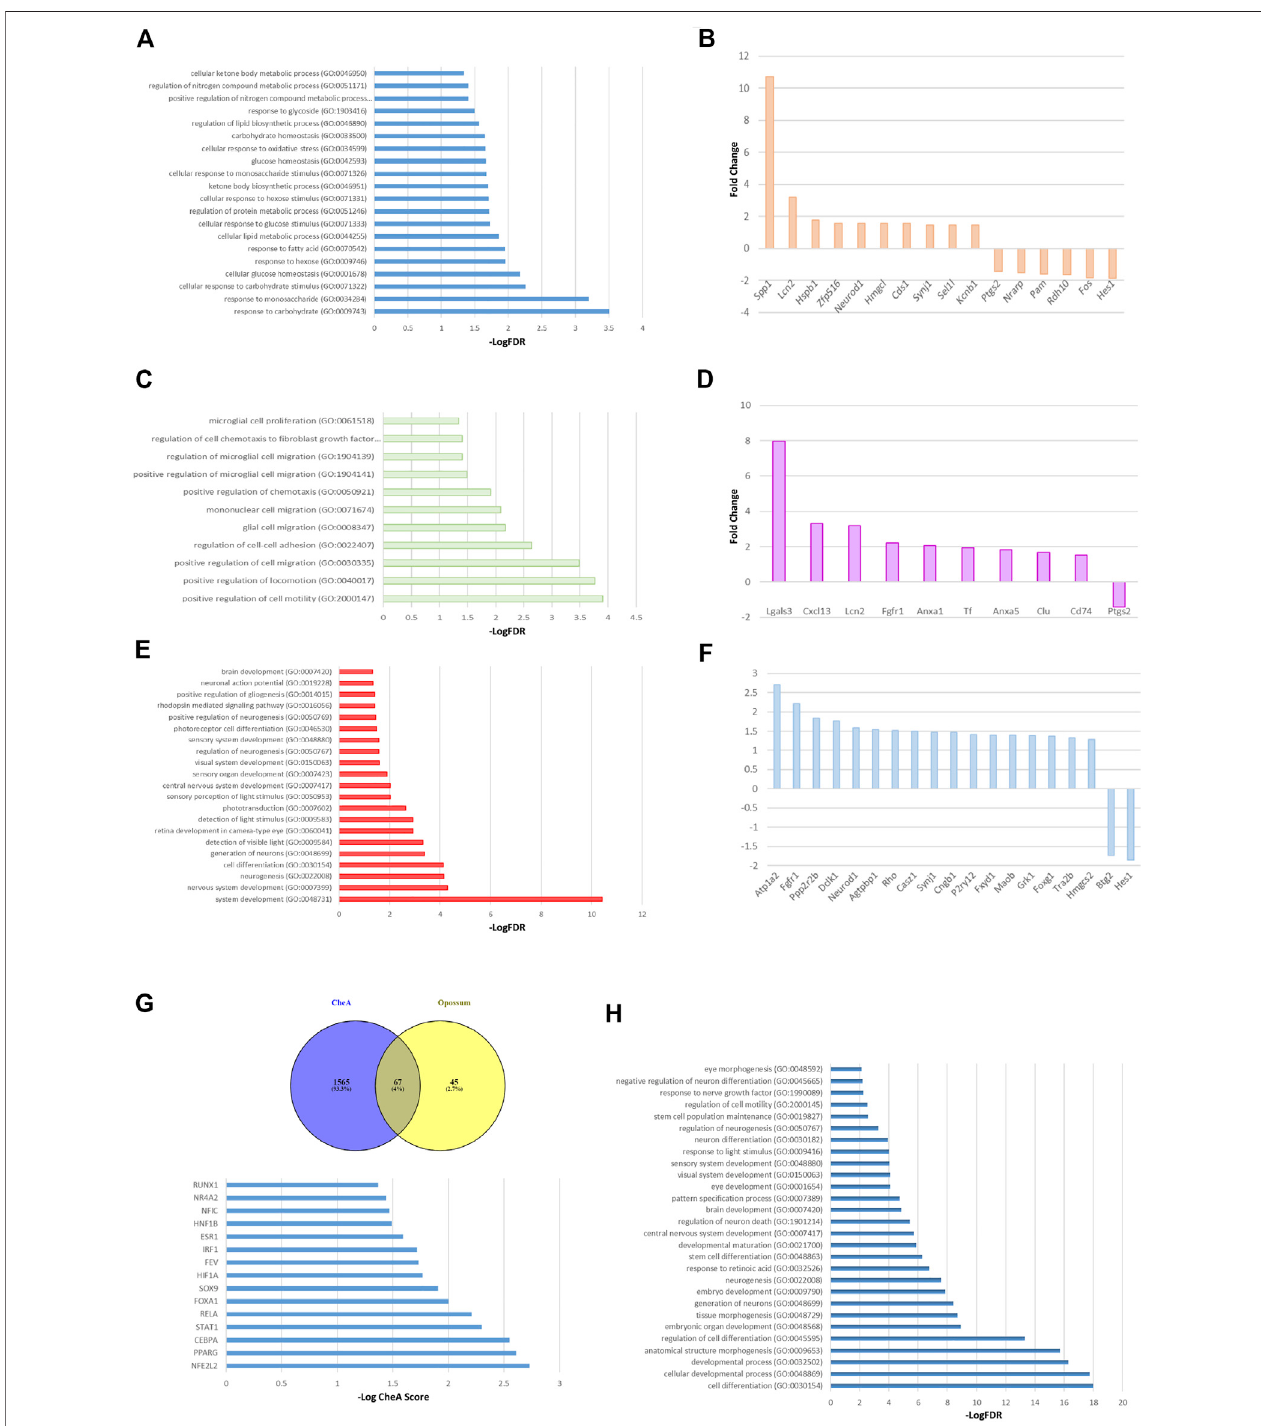
FIGURE 6 | Transcriptomic analysis of Müller glial cells from a murine model of Diabetes. GO enrichment analysis of the 163 altered mRNAs shows the GO terms associated with metabolic processes (A) , migration and motility pathways (C) and cellular differentiation processes (E) , specially focused on neurogenesis, brain and visual sensory organs development. The top ten of upregulated and downregulated genes associated with the metabolic processes, glial cells migration and cell reprogramming are described in panels (B, D, F) respectively. (G) The top panel shows the transcription factors that could explain the changes in diabetic MGs geneexpressionsharedbetweenChEAandOpossumenrichmentanalysis.Lowerpaneldepictsthetop15transcriptionfactors,intermsofChEAscore,thatexplainthe transcriptome of diabetic MGs. (H) GO analysis using the 67 predicted transcription factors. Only the GO terms associated with development, specially brain and eye development, are shown.